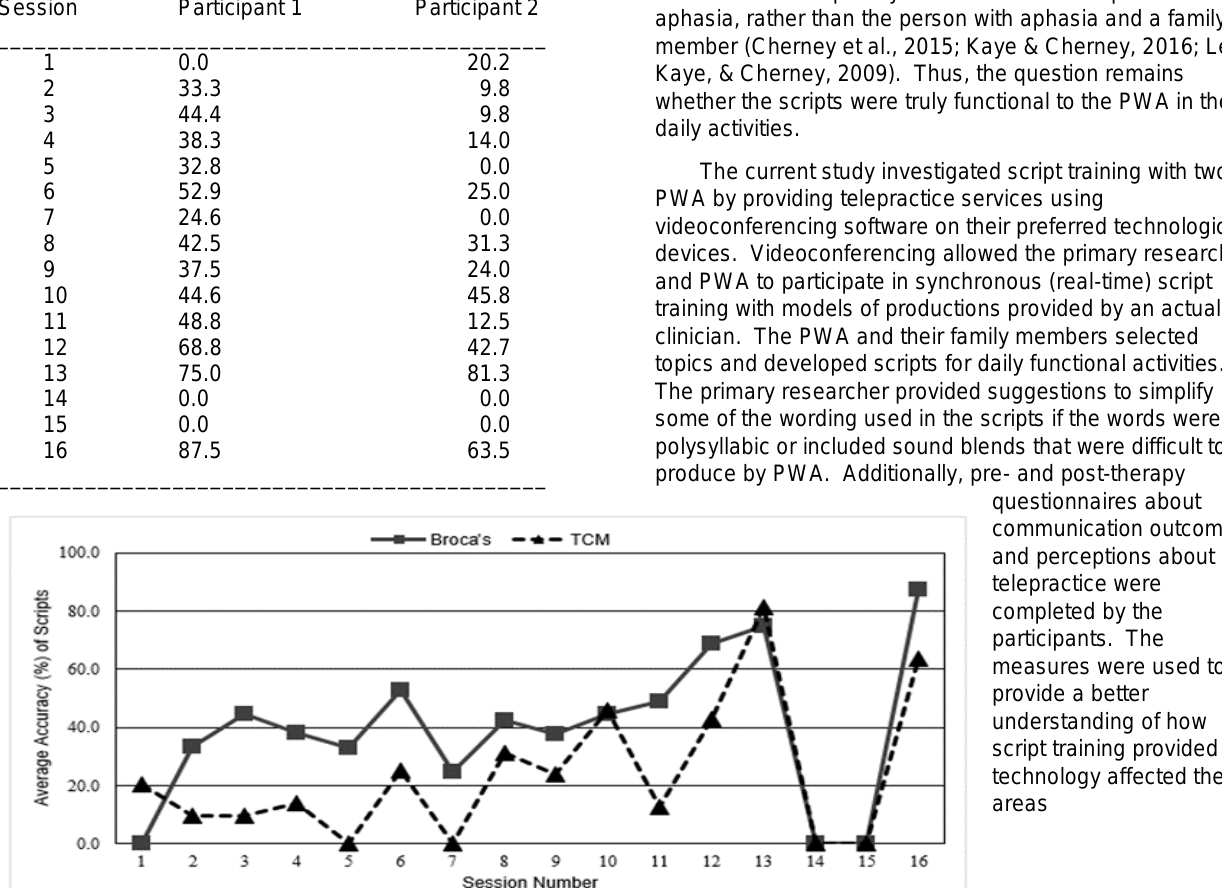
Table 5. Average Percent Accuracy of Baseline Data Collected During 13 Sessions of Script